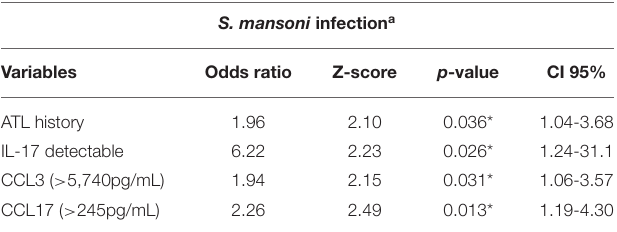
TABLE 6 | Multiple regression model showing the association between S. mansoni infection with serum levels of immune mediators and previous report of ATL in individuals living in the rural community of Brejo do Amparo, Januária, Minas Gerais,